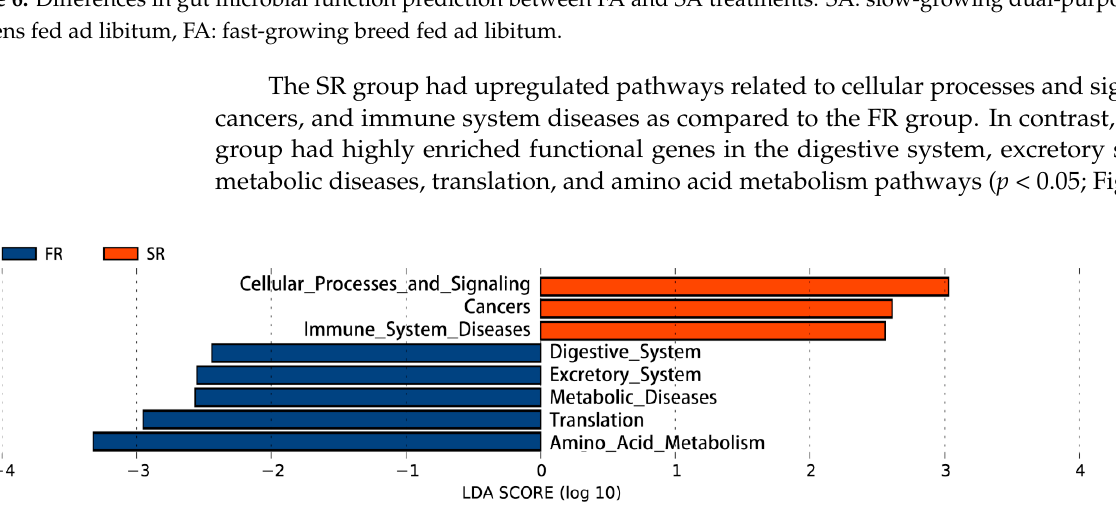
Figure 7. Comparison of predicted gut microbial function between the FR and SR treatments. FR: fast-growing broilers under feed restriction, SR: slow-growing dual-purpose chickens under feed restriction.